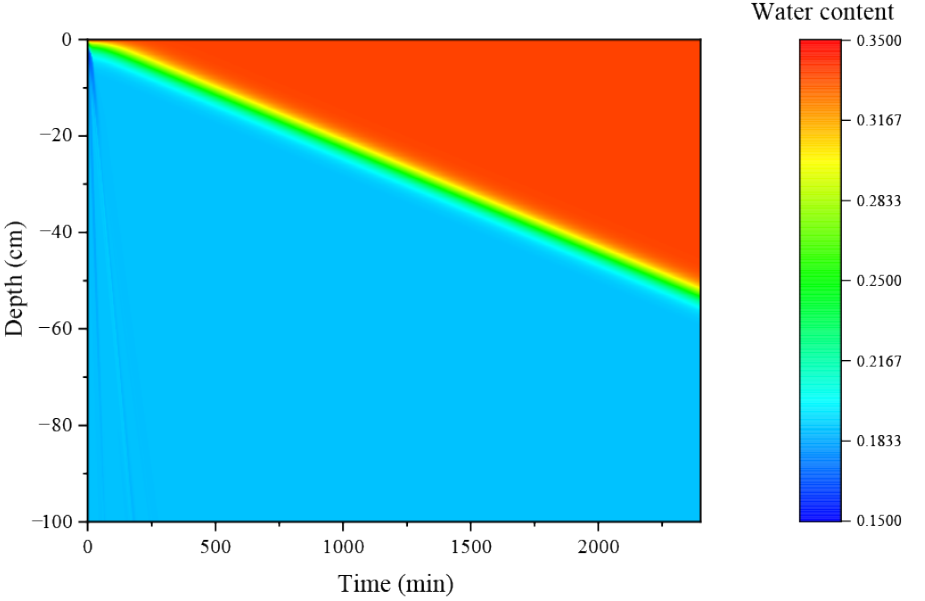
Figure 12. The results of the numerical prediction of soil–water infiltration in medium-loam soils over time.